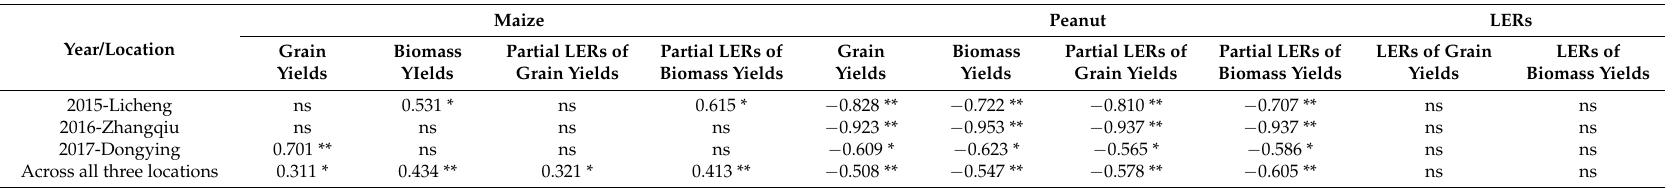
Table 3. Pearson correlation coefficients between grain/biomass yields and maize densities in intercropping, and between partial/total land equivalent ratios (LERs) of grain/biomass yields and maize densities in intercropping in each experimental location ( n = 15) and across all three locations/years ( n =